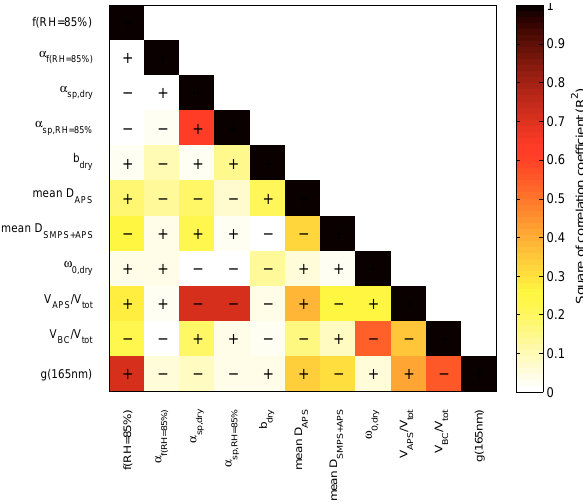
Fig. 3. Correlation plot of all intensive aerosol parameters measured in-situ at the Cabauw tower. f (RH=85%, 550nm): scattering enhancement factor; α f ( RH ) : ˚Angstr¨om exponent of f (RH=85%, 550nm); α sp , dry : ˚Angstr¨om exponent of scattering coefficient at low RH; α sp , RH = 85% : ˚Angstr¨om exponent of scattering coeffi- cient at RH=85%; b dry : backscatter fraction (at λ = 550nm) at low RH; D APS : mean (dry) diameter of APS size distribution measurement; D SMPS : mean (dry) diameter of SMPS size distri- bution measurement; ω 0 , dry : single scattering albedo at low RH (at λ = 550nm); V APS /V tot : coarse mode fraction measured by APS and SMPS; V BC /V tot : black carbon volume fraction mea- sured by MAAP, SMPS, and APS; g (RH=90%,165nm): hygro- scopic growth factor measured at the dry diameter d 0 = 165nm and at RH=90% by the H-TDMA. Plus and minus signs indicate the slope of the regression line.